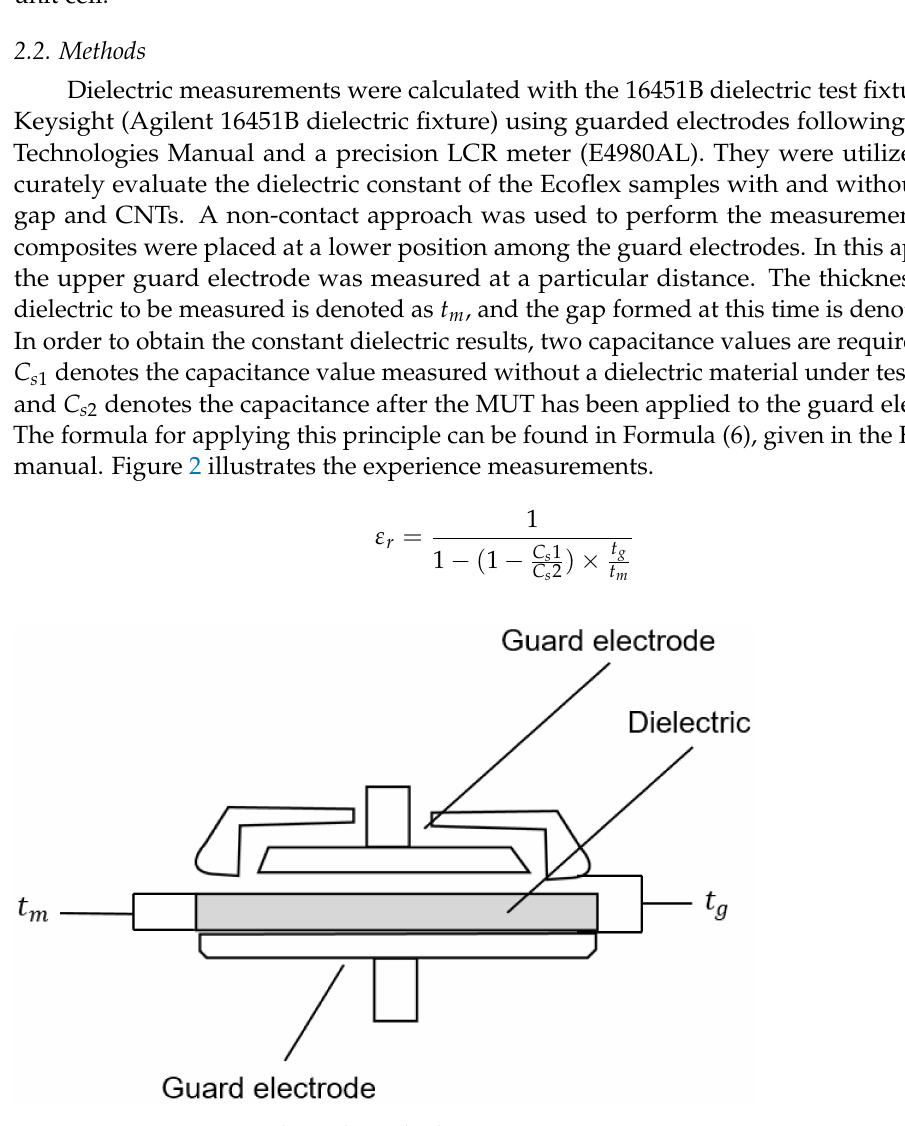
Figure 2. Non-contacting electrode